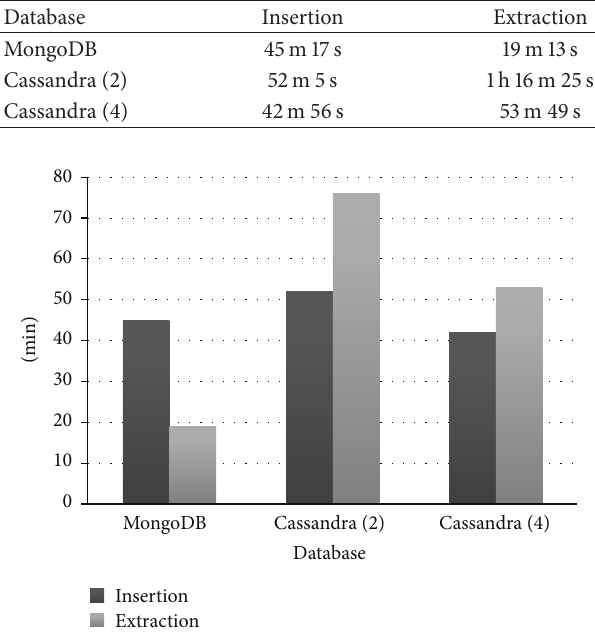
Table 4: MongoDB and Cassandra final results.